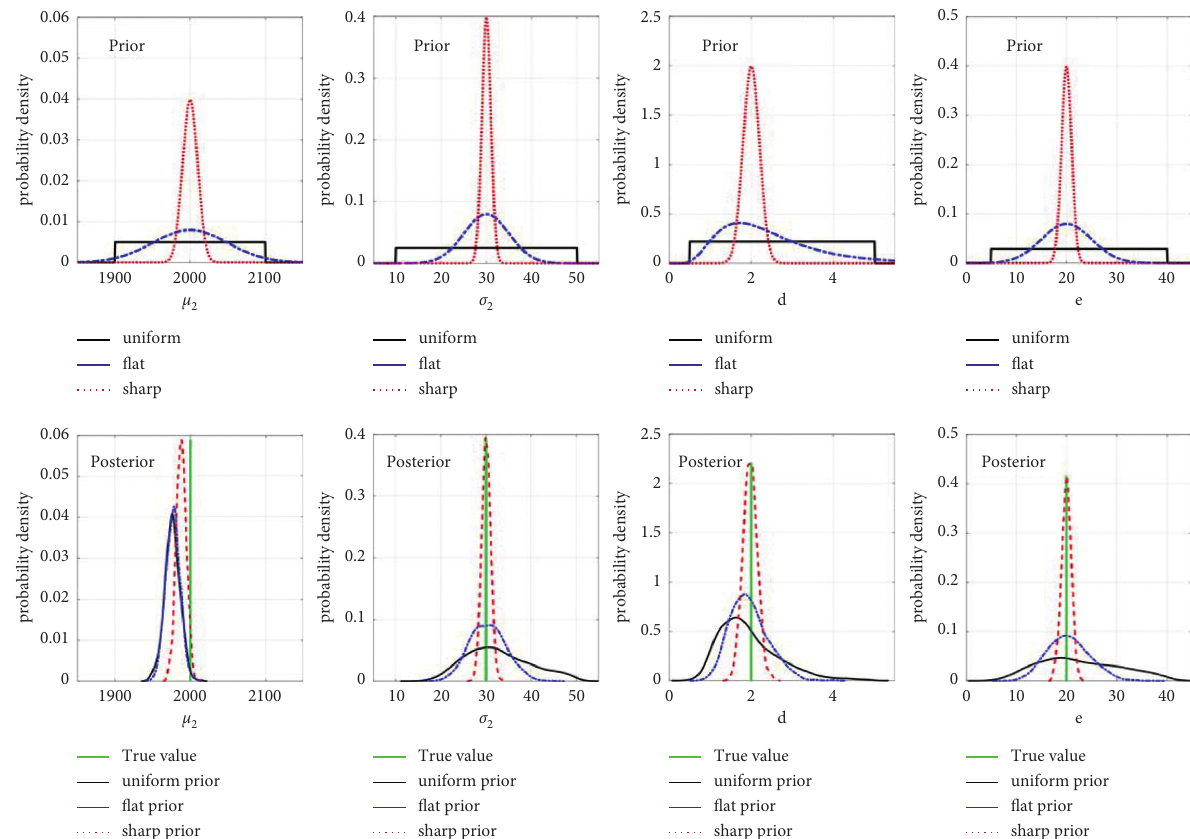
Figure 10: Comparison of the posterior PDFs for each hyperparameter according to different